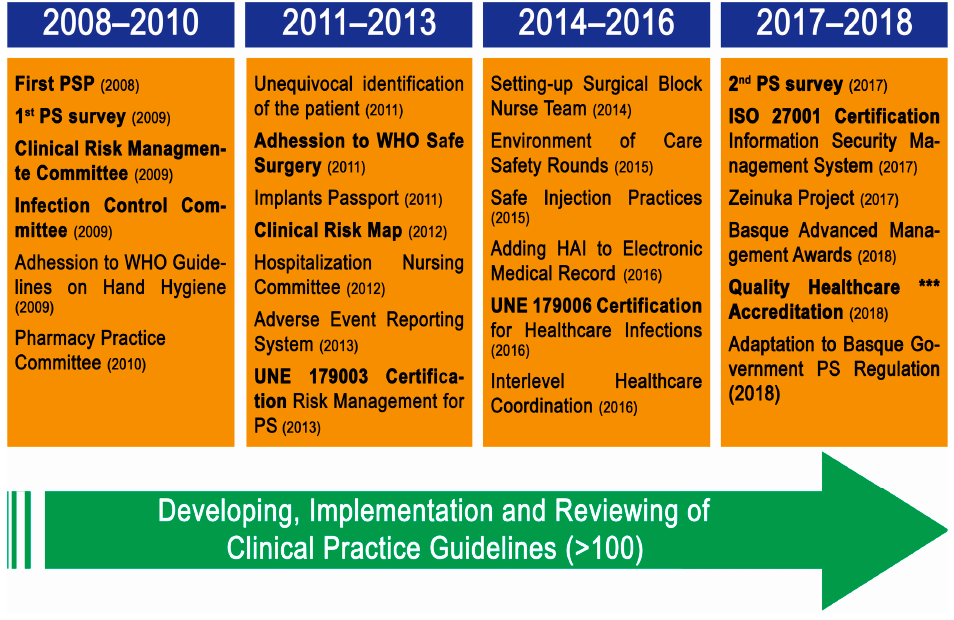
Figure 1. Timeline of the implementation of strategies promoting Patient Safety (PS) at Mutualia.